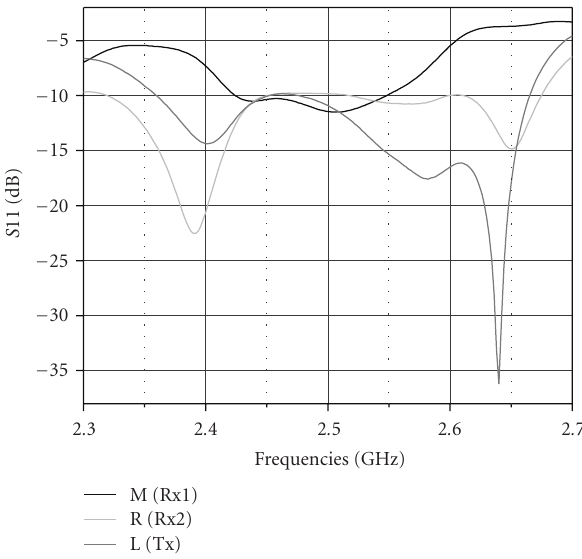
Figure 19: Return loss S 11 measurements for MIMO system.